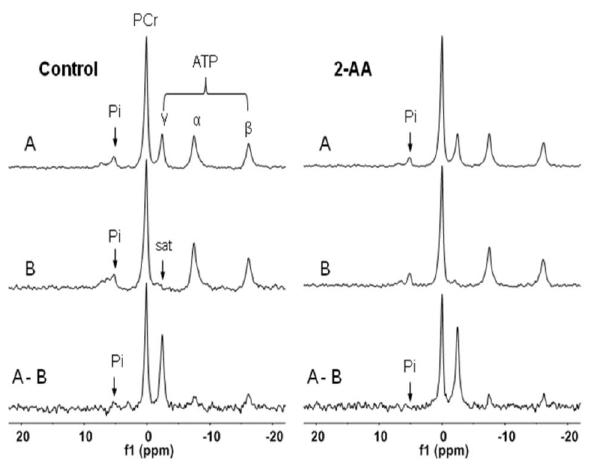
Figure 1. NMR spectra of invivo 31 P NMR saturation-transfer on mouse hind limb skeletal muscle. Representative summed 31 P-NMR spectra acquired from control and 2-AA treated mice at day 4, before (A) and after (B) saturation of the c -ATP resonance, with the difference spectrum between the two shown below (A–B). The arrow on c -ATP indicates the position of saturation (sat) by rf irradiation ( 2 2.4 ppm). ppm, chemical shift in parts per million.